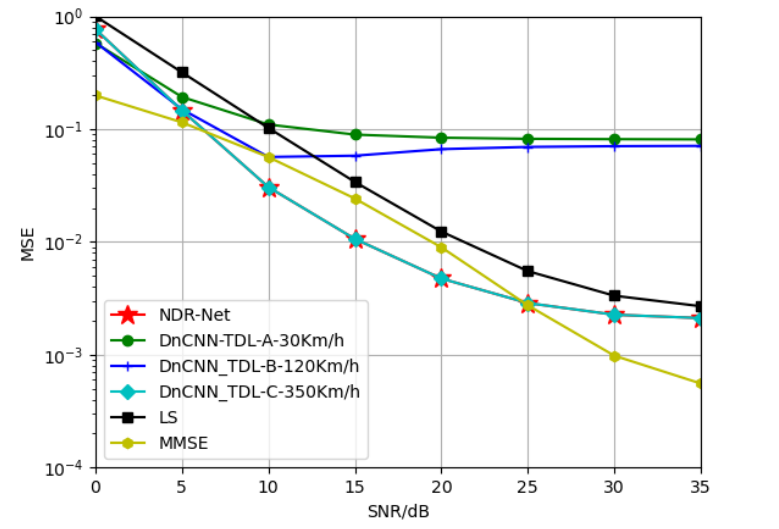
Figure 11. Generalization performance of different channel estimators when the training SNR = 15 dB and the testing channel is